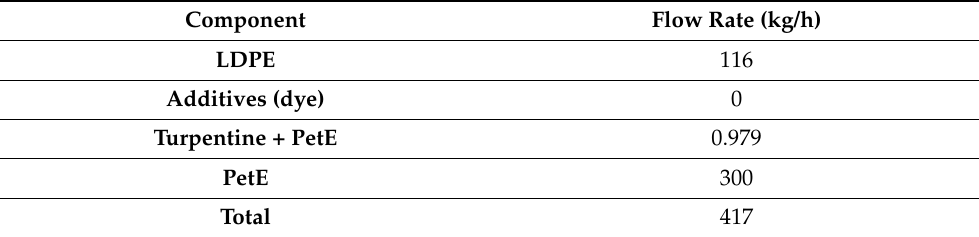
Table 6. Feed stream components flow rate.